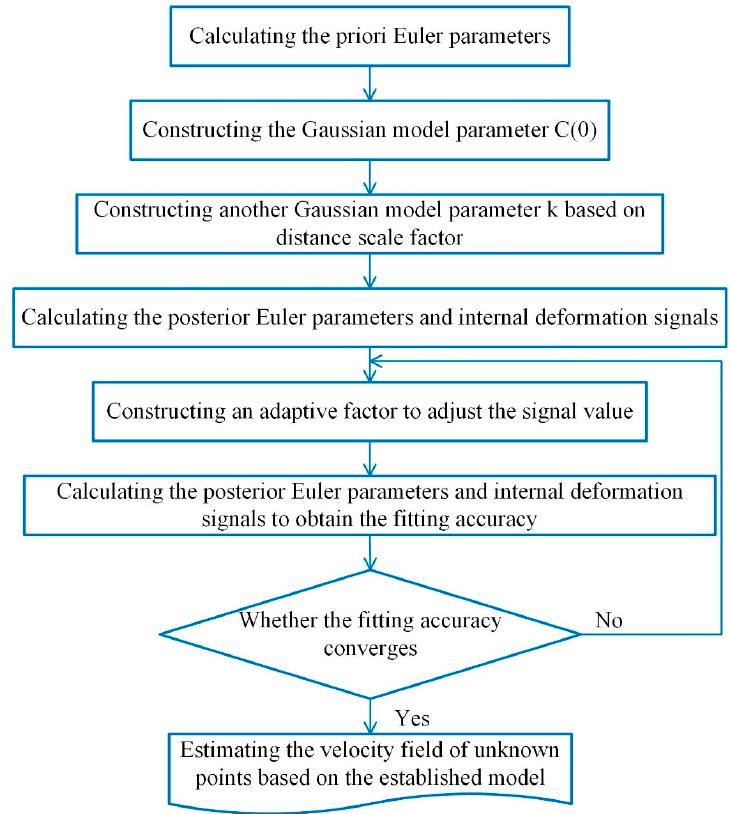
Figure 1. The frame diagram of the an adaptive least-squares algorithm considering the distance scale factor (ADLSC algorithm).